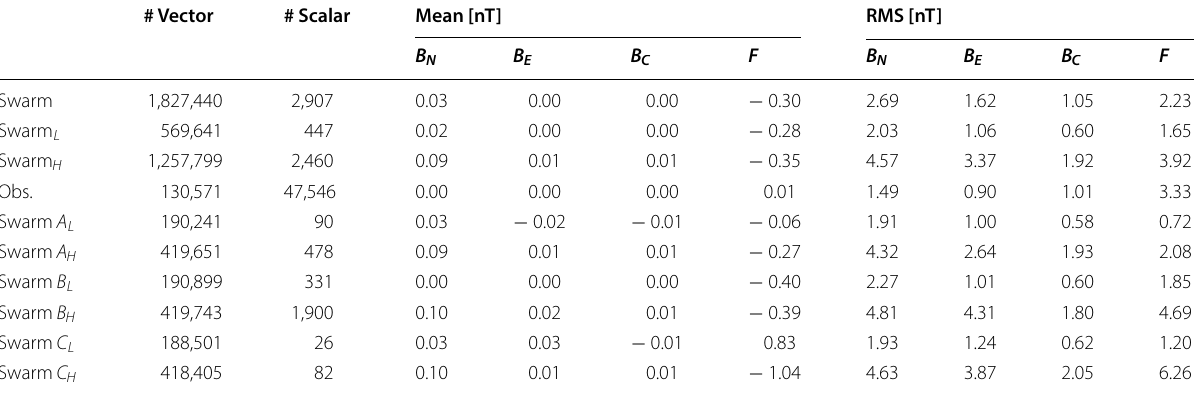
Misfit values are weighted by prior data covariance and the final Huber weighting of residuals. Satellite data with subscript ‘L’ indicate data at GMD latitudes below |55 ◦ |, values with subscript ‘H’ indicate data at GMD latitudes above |55 ◦ |. Observatory vector and projected scalar data are only used in the regions below and